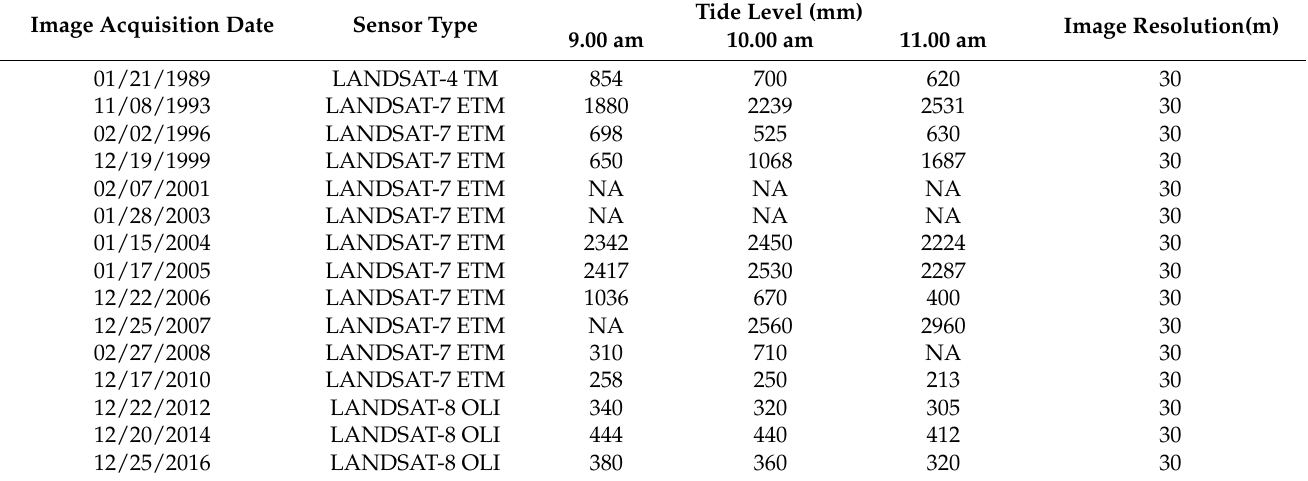
Table 1. Acquisition dates of LANDSAT images, resolution of each image, and sea level at Cox’s Bazar station at the image acquisition